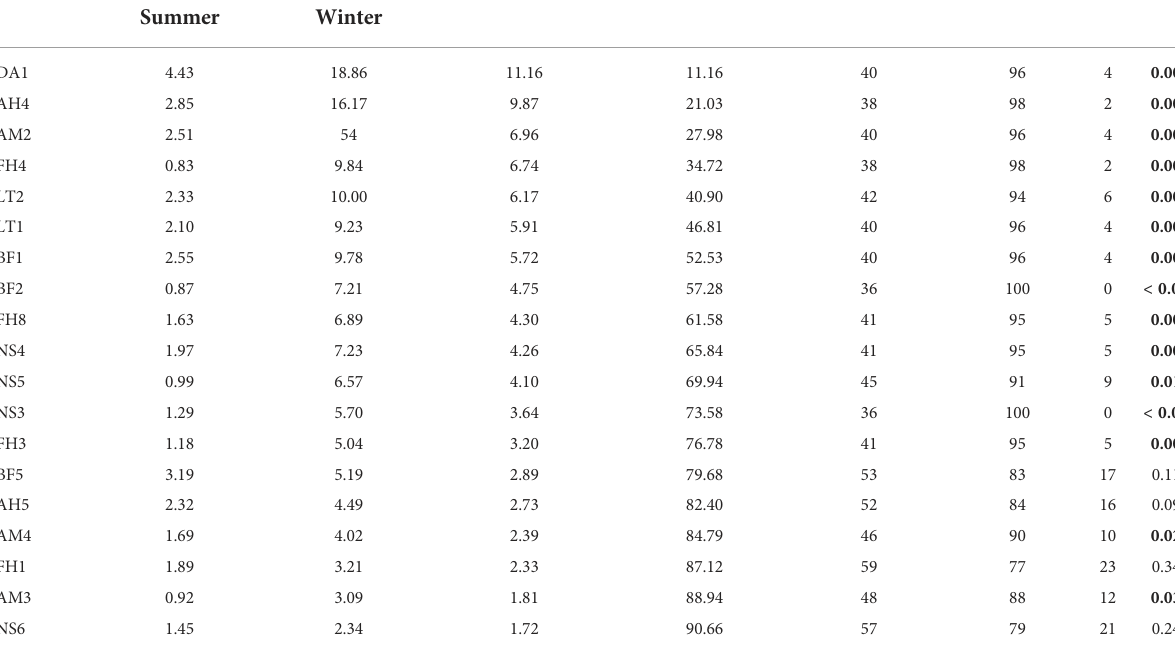
TABLE 4 Results of contribution of biological trait categories from SIMPER analysis and Mann-Whitney U test between seasons.